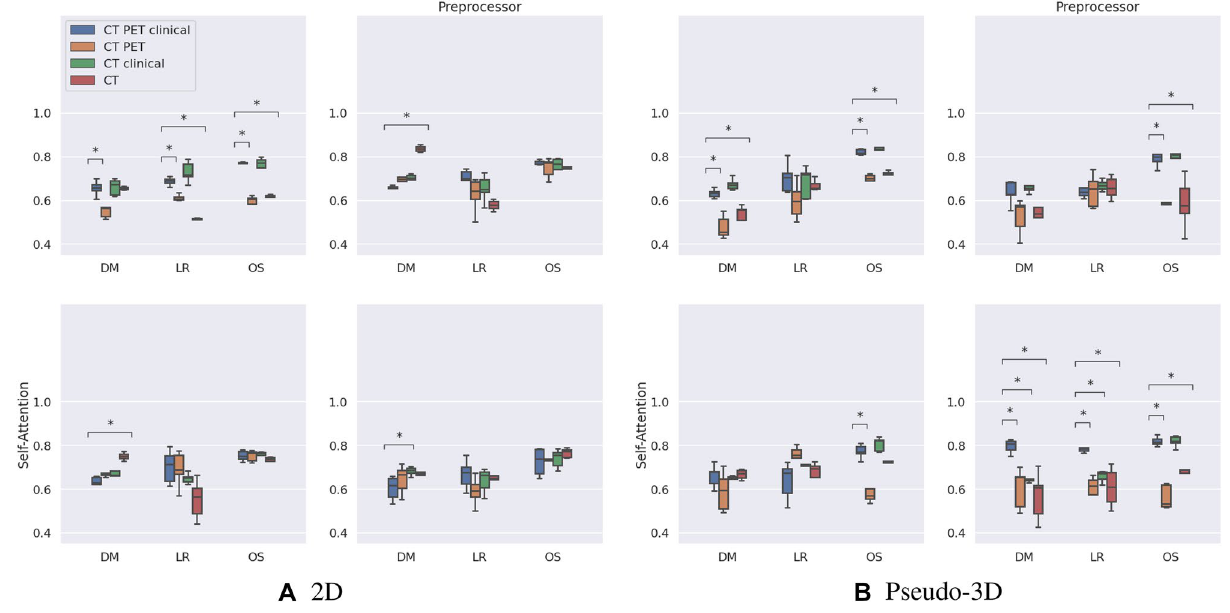
Figure 2. Ablation AUROC results for the proposed PreSANet model. Subfigure grids represent ablations of the Preprocessor and self-attention features for the ( A ) 2D variant, and ( B ) pseudo-volumetric variant. Within each sub-figure, the combination of input imaging and clinical modalities are presented. Figures presented are mean performance over 5 repeated trials with error bars representing 95% CI. Stars indicate statistical significance using the dependent t-test for paired samples with Bonferroni correction, with the number of stars indicating: (1) p < 0.05 , (2) p < 0.01 , (3) p < 0.001 , (4) p < 0.0001 . Each modality combination is compared with the proposed model that uses CT image, PET image and clinical data as inputs. Training and validation split employed matched the one presented by Vallieres et al. 30 . Figure created with seaborn/matplotlib v0.11.2 (seaborn.pydata.org)